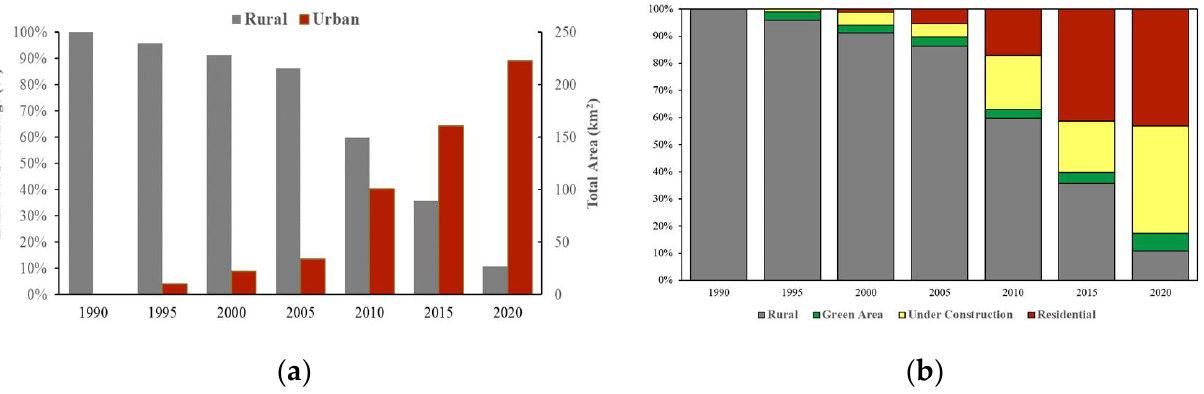
Figure 7. Land use historical changes between 1990 to 2020; ( a ) shows the total area in km 2 and percent change; ( b ) shows land use percentages which can significantly affect runoff values.